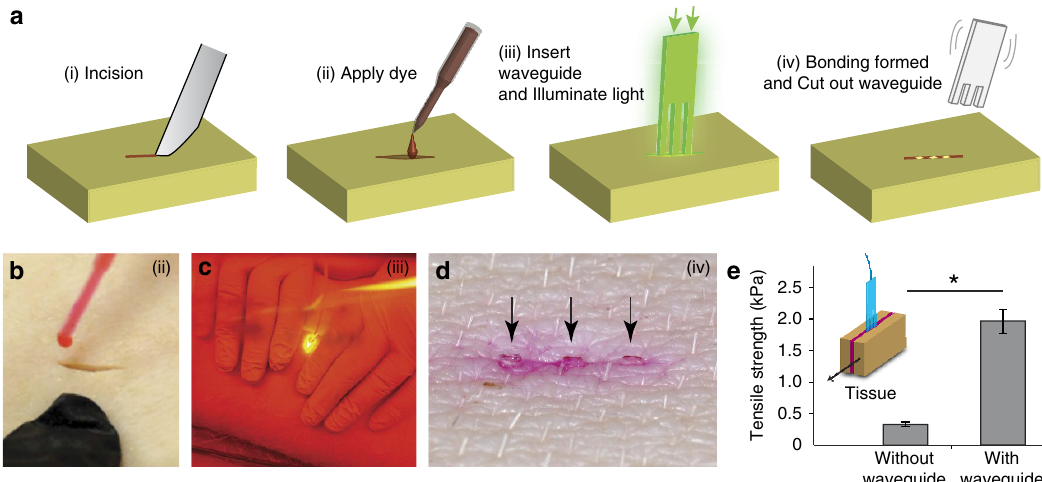
Figure 5 | Waveguide-assisted photochemical tissue bonding. ( a ) Schematic of the experimental procedure. (i) A full-thickness skin incision is performed. (ii) Rose Bengal dye is applied to the surfaces of a wound in porcine skin, and the excess solution is removed. (iii) A waveguide is inserted into the wound, and light is delivered to the waveguide through an optical fibre. (iv) After the procedure, the waveguide is trimmed away close to the skin surface. ( b – d ) Photographs showing steps (ii), (iii) and (iv). The arrows in d indicate the position of the waveguide inside the tissue. ( e ) Shear tensile strength of PTB bonds formed ex vivo in porcine skin. PTB bonds formed using a waveguide show more than fivefold increased bonding strength compared with conventional superficial illumination of the skin. * P value o 0.01 in t -test ( N ¼ 3). The errors bars represent the